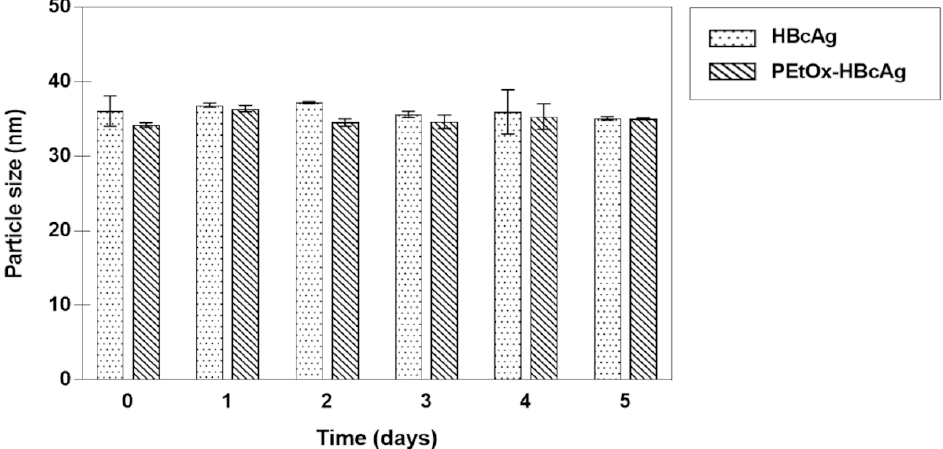
Figure 4. Colloidal stability of HBcAg and PEtOx-HBcAg VLNPs in Tris-buffered saline (TBS) over five days at 37 °C. Measurements of particle size were performed daily in triplicate ( n = 3), and the error bars represent the standard deviations from triplicate measurements.